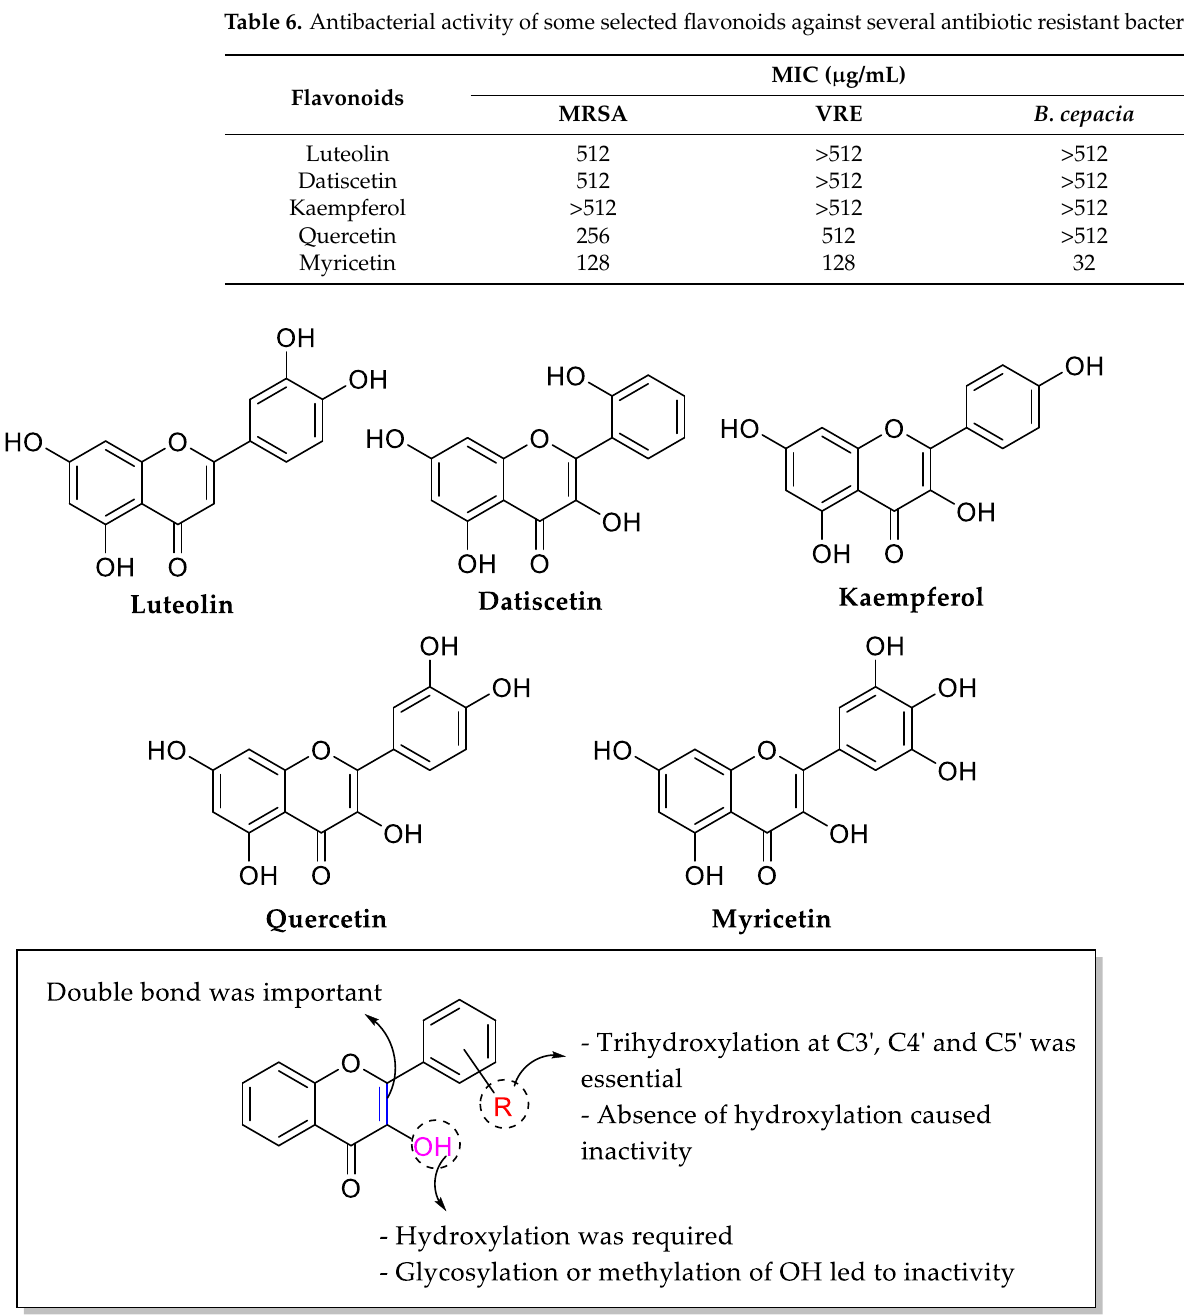
Figure 11. Chemical structures of tested flavonoids that were active and the structural feature requirements for the manifestation of flavonoids’ antibacterial activity against antibiotic resistant bacteria [64].